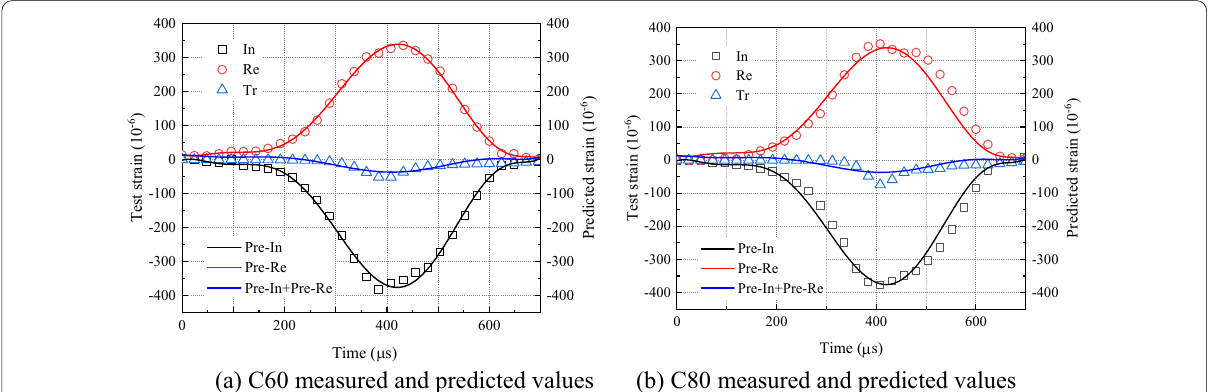
Fig. 10 Measured and predicted strain–time response of SHPB incident, reflected and transmitted rods under high strain